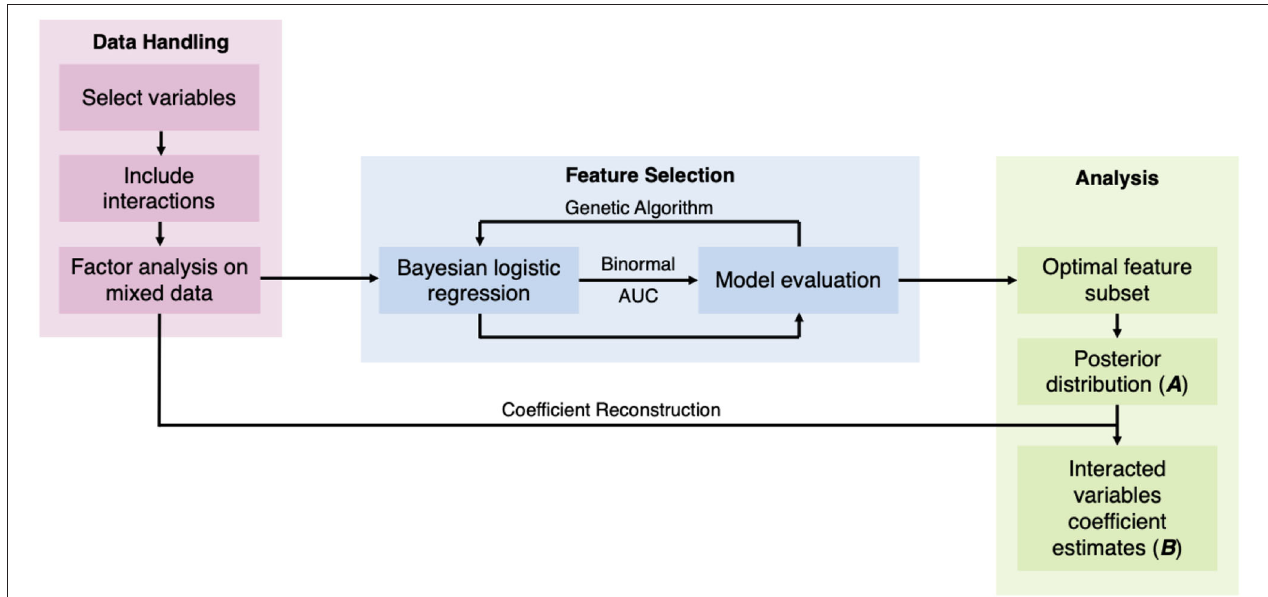
FIGURE 1 | Study methods